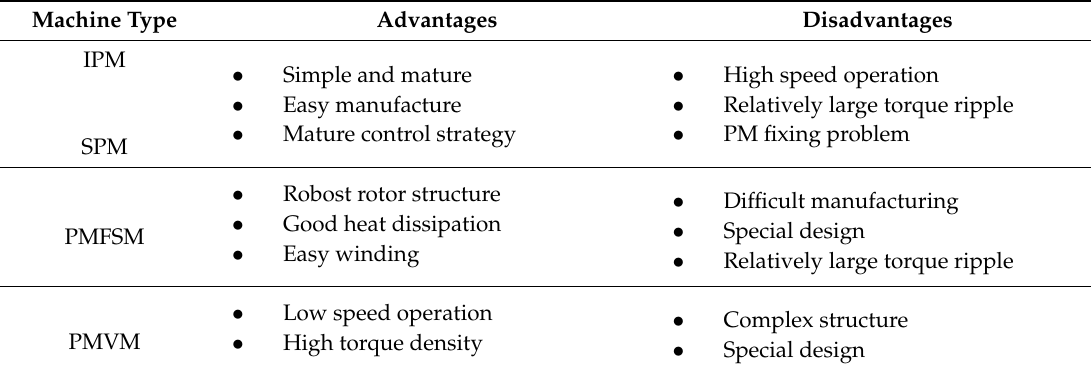
Table 1. Comparison of Four Proposed Types of